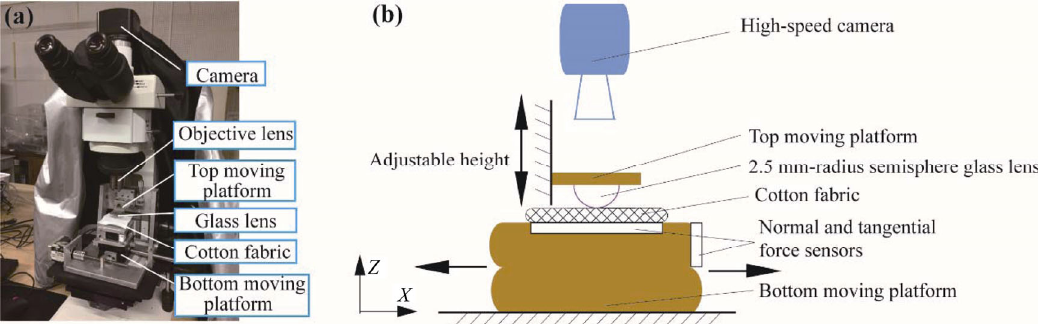
Fig. 2 (a) Image of the tribotester and (b) schematic of the cotton fiber tribology test